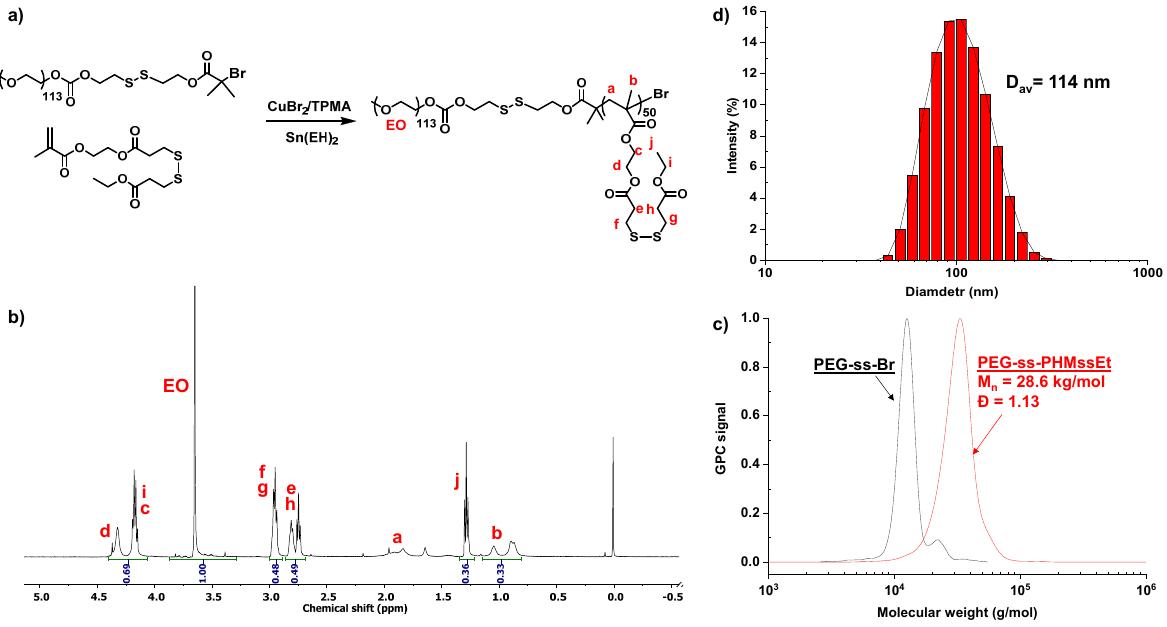
Figure 1. Synthetic scheme ( a ), 1 H-NMR spectrum in CDCl 3 ( b ), GPC chromatogram ( c ), and self-assembled micelles ( d ) of a well-defined ssABP.